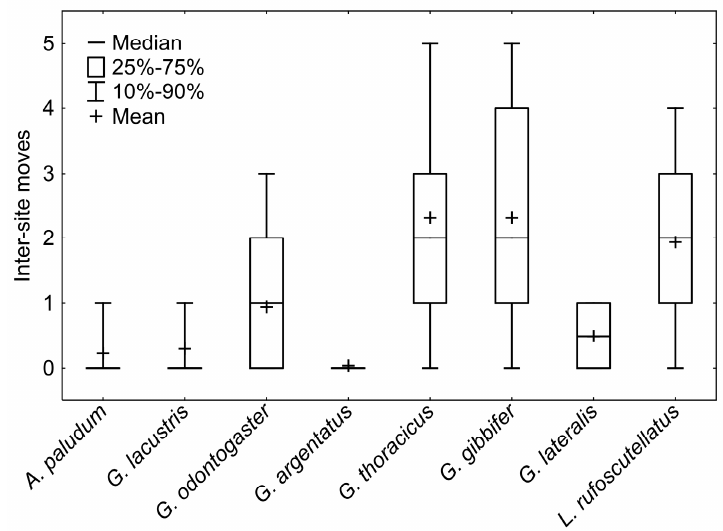
Figure 7. A comparison of intersite movements among particular species. A. paludum , G. lacustris, and G. argentatus are rather philopatric, G. odontogaster is intermediate, and G. thoracicus , G. gibbifer, and L. rufoscutellatus are frequent flyers. Only two individuals of G. lateralis were recaptured, and thus this species cannot be sorted into any of the above groups.